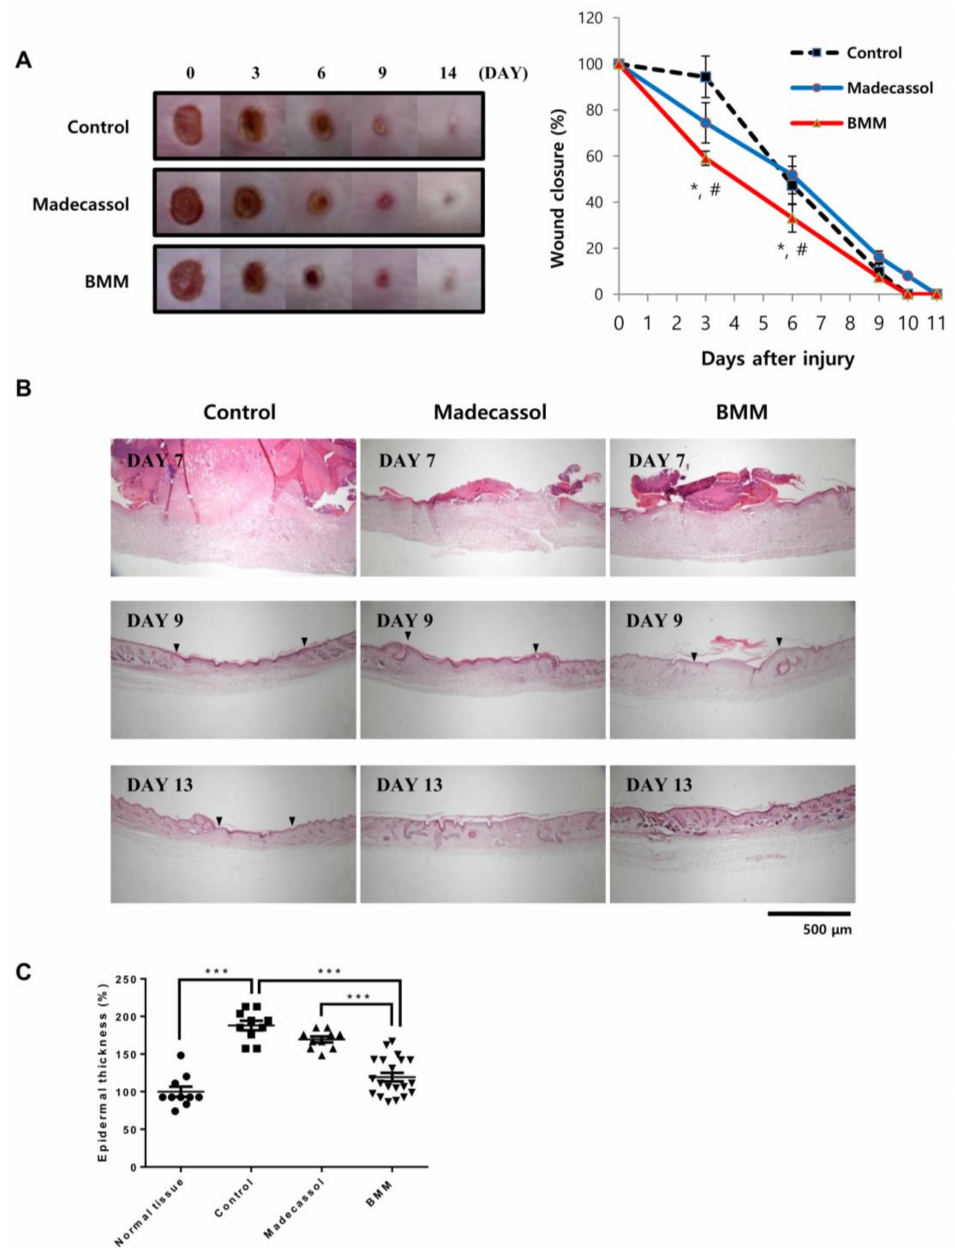
Figure 6. BMM accelerates wound healing in an in vivo excisional wound model. ( A ) Wound closure in an excisional wound model over 14 days. Photographs were taken every three days, and wound size was measured using the ImageJ software. ‘Control’ indicates the butylene glycol and “Madecassol” was used for a positive control. The rate of wound closure is shown as a graph. * p < 0.05 as compared to the control, and # p < 0.05 as compared to Madecassol; ( B ) Hematoxylin&Eosin staining of skin tissue isolated from the wound site on indicated days; ( C ) Epidermal thickness was measured 13 days after wounding using the Image J program. *** p < 0.001. Dotted line; re-epithelialization, arrowhead; wound edge, and arrow; regenerated skin appendages. Epidermal thickness shown as a